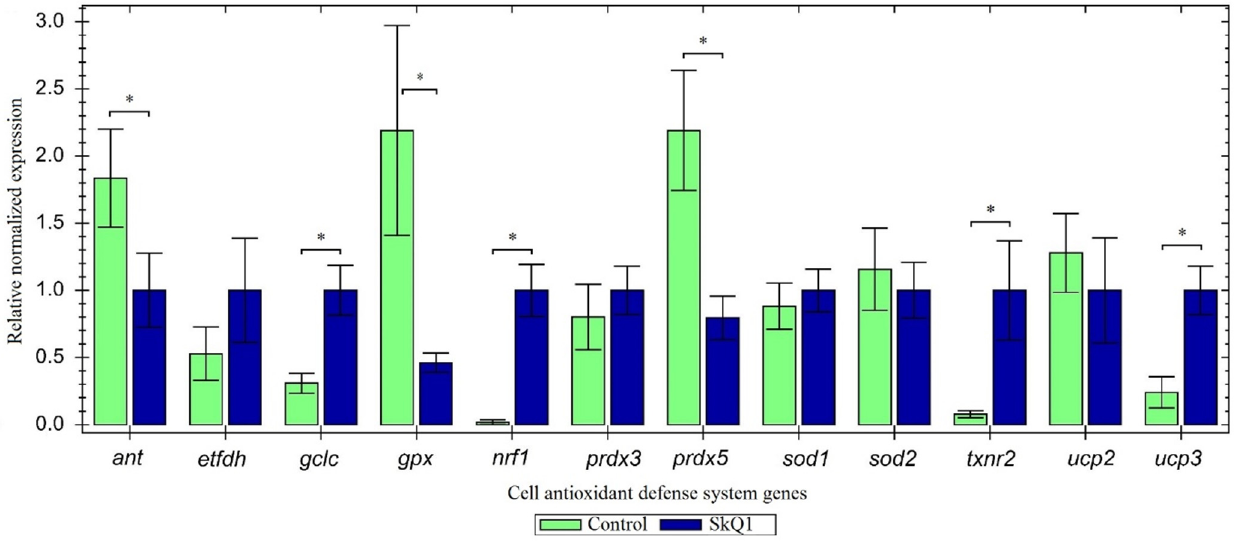
Figure 3. Effect of antioxidant SkQ1 on gene expression (* p ≤ 0.05). SkQ1 injection increased the expression of the gclc gene and the gene for its tran- scription factor ( nrf1 ). Apparently, SkQ1 takes on the main antioxidant function, which